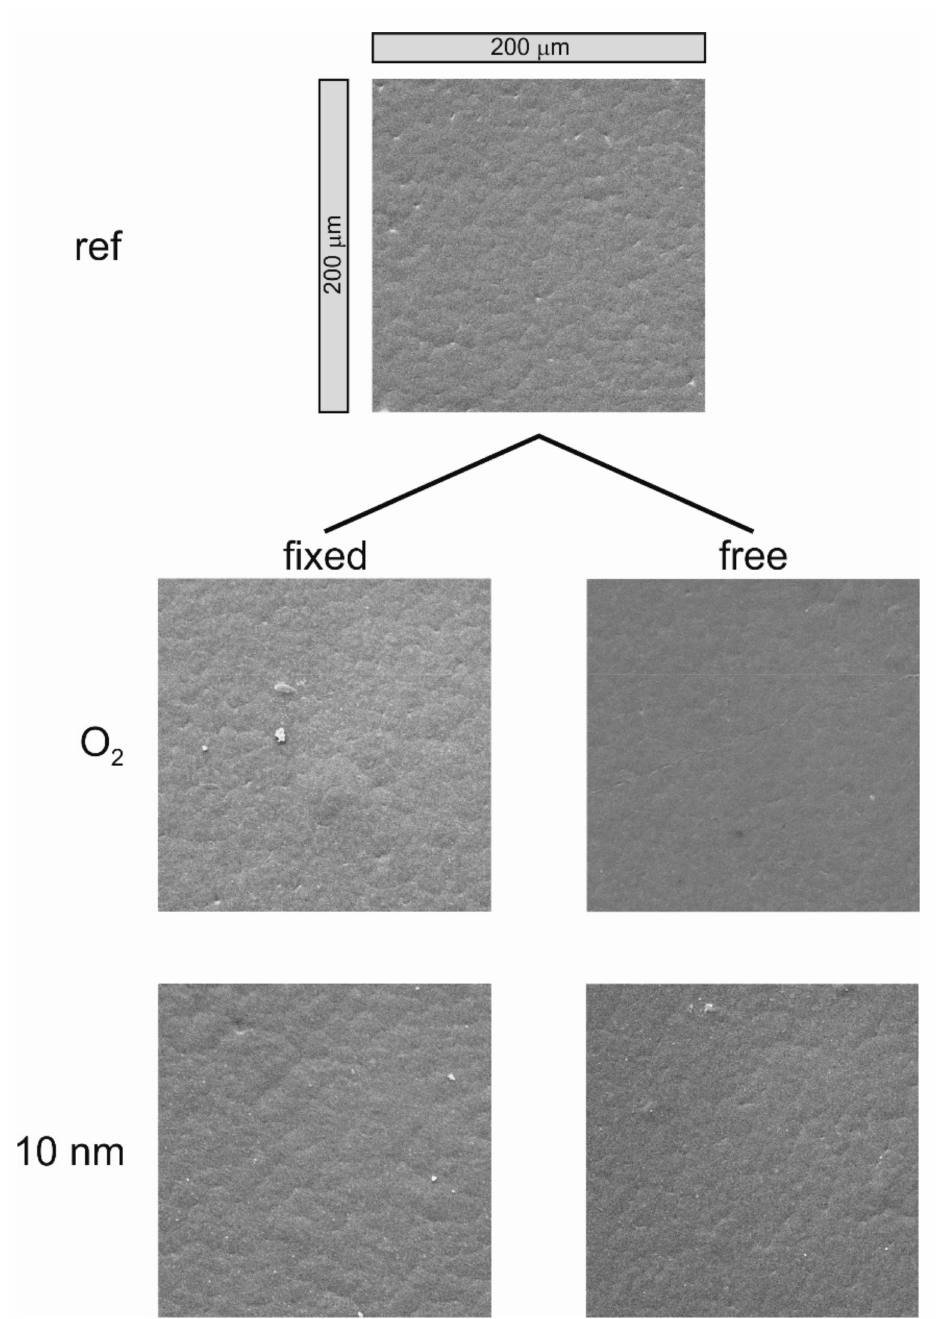
Figure 3. SEM images of the raw PHB, O 2 treated samples and 10 nm layer thickness for the “fixed” and “free”